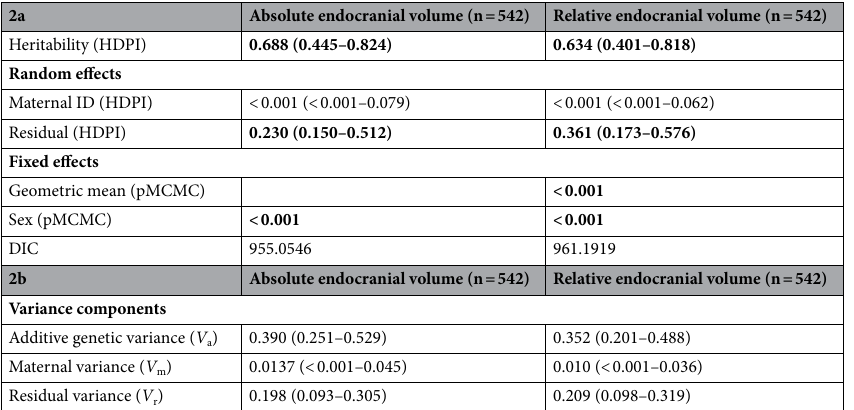
Absolute endocranial volume (n = 542) Relative endocranial volume (n =